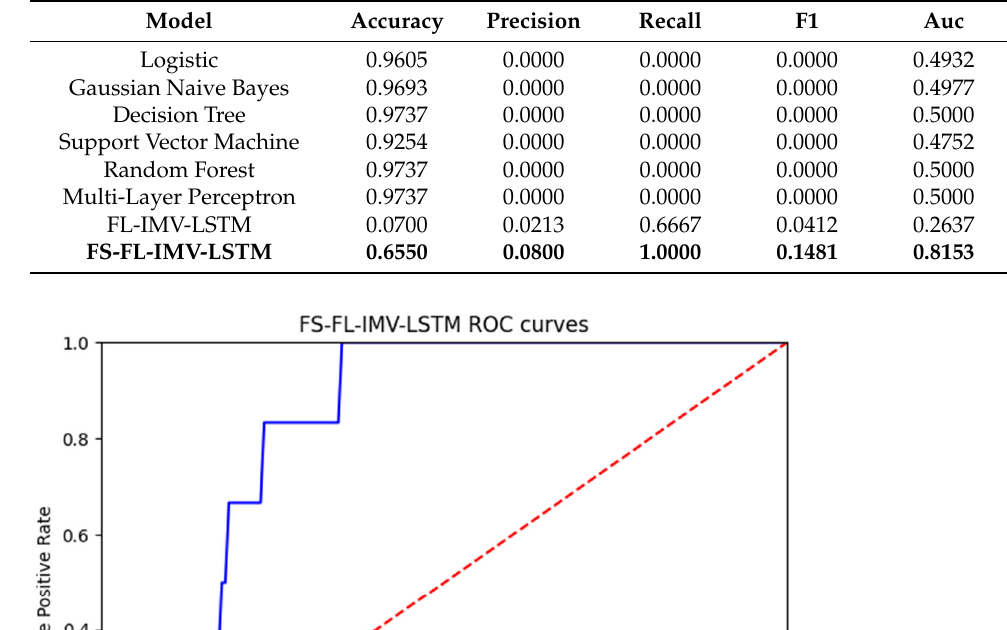
Table 8. Prediction Performance.